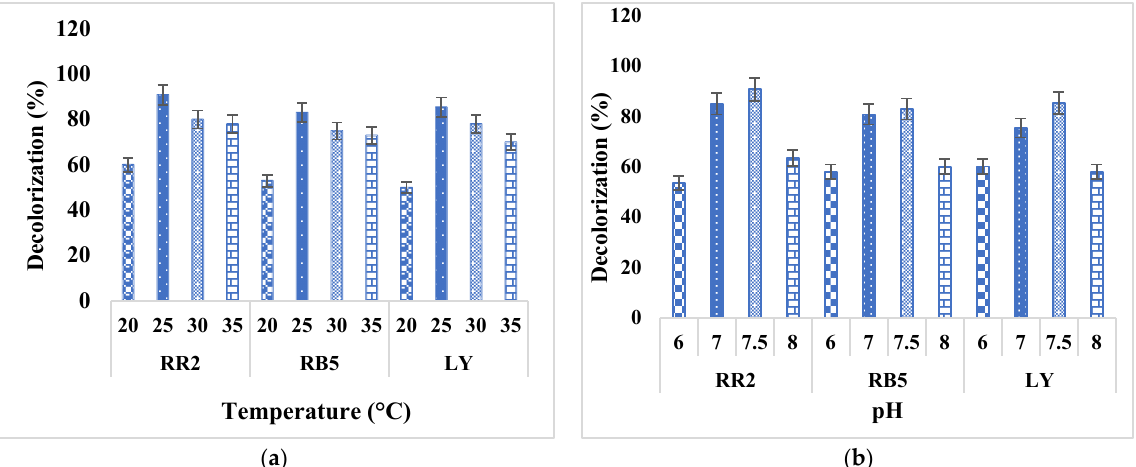
Figure 3. Decolorization of azo dyes by Paramecium caudatum UR03, ( a ) at different temperatures (20, 25, 30 and 35 ° C ) and ( b ) different pH (6, 7, 7.5 and 8).